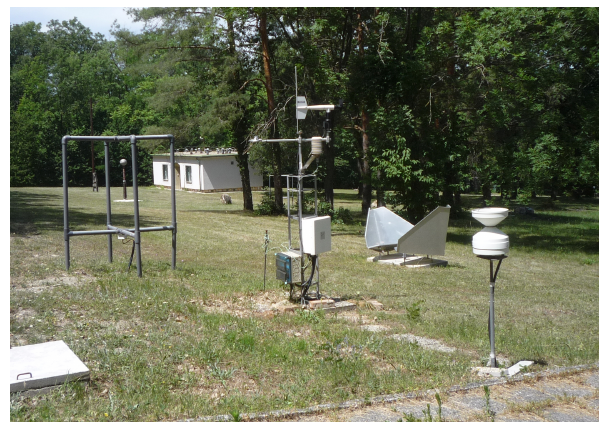
Figure 8. The meteorological station with the tipping bucket (in the foreground) at NCK. The photo also shows one of the four receivers of the Lowell ionosonde (to the left) with the Schumann resonance electric ball antenna and the atmospheric-electricity house in the background and the SAR reflector (to the